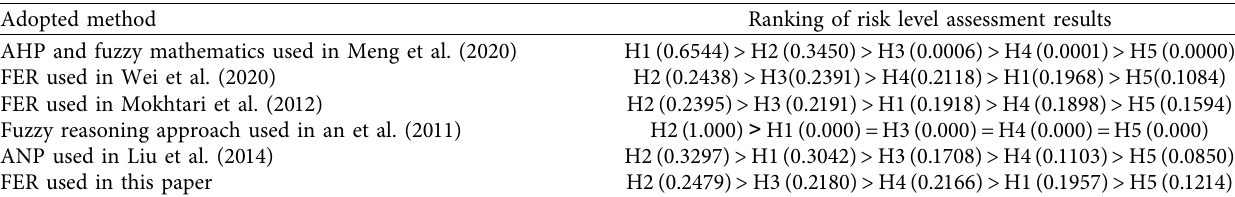
Table 22: The comparison of results obtained by using five methods respectively.